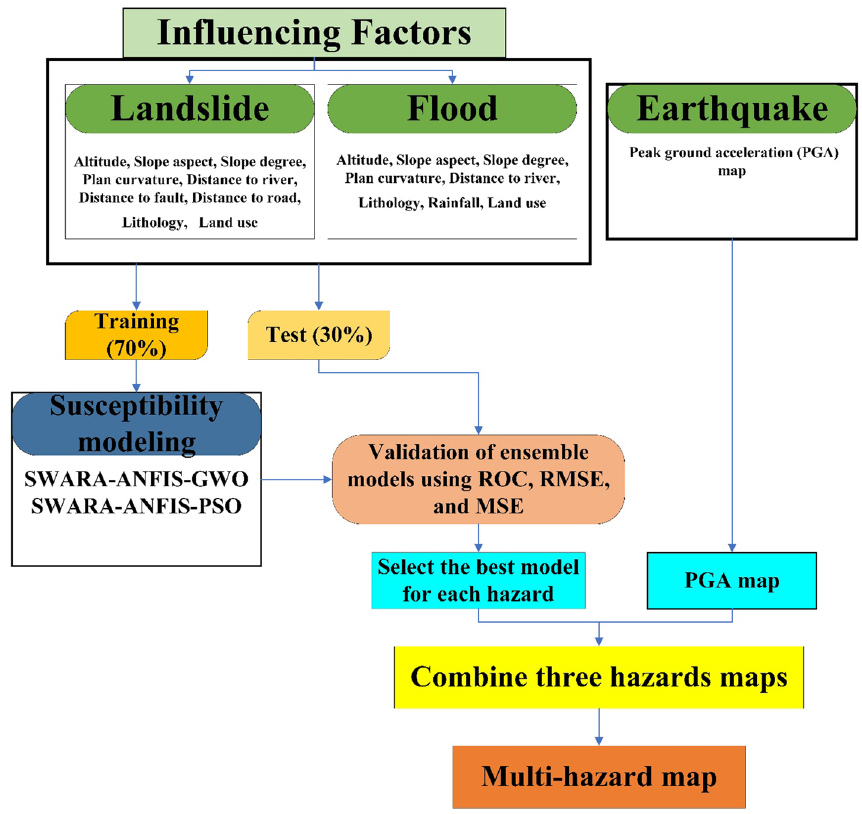
Figure 9. Methodological flowchart of the modeling steps for providing a multi-hazard map in the Kermanshah